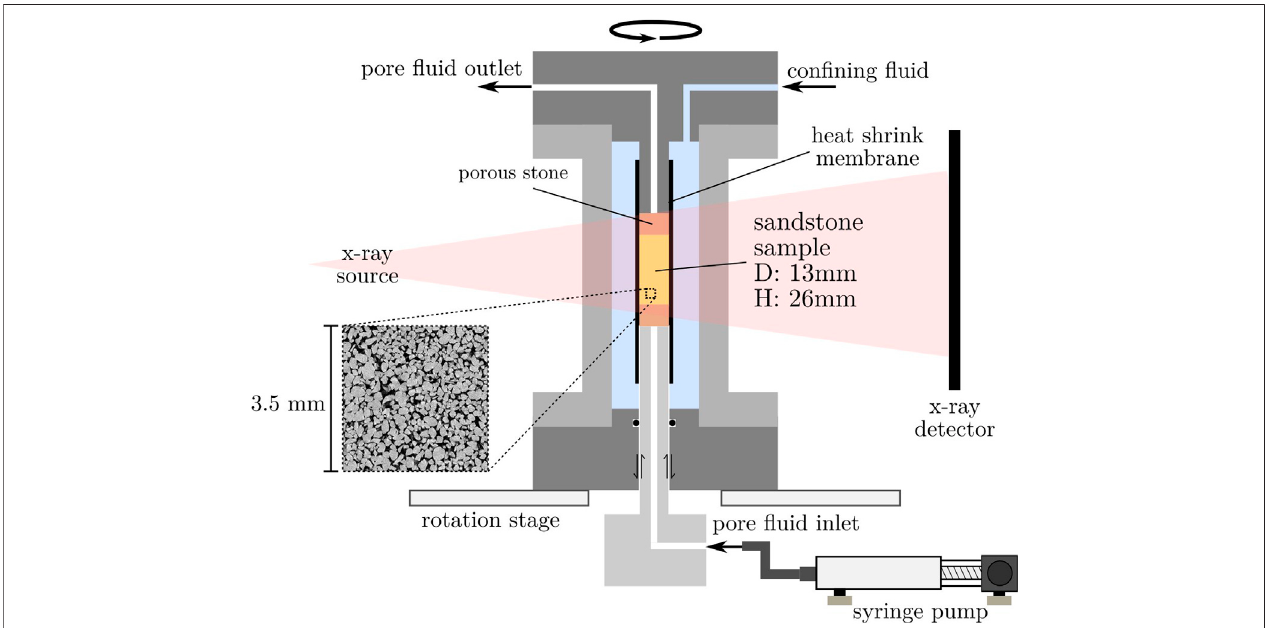
FIGURE 2 | Schematic view of the different components of the fl uid injection triaxial system and syringe pump. This con fi guration enables radiography and tomography imaging of the whole sample. A representative view of the pore structure is shown in the magni fi ed inset.